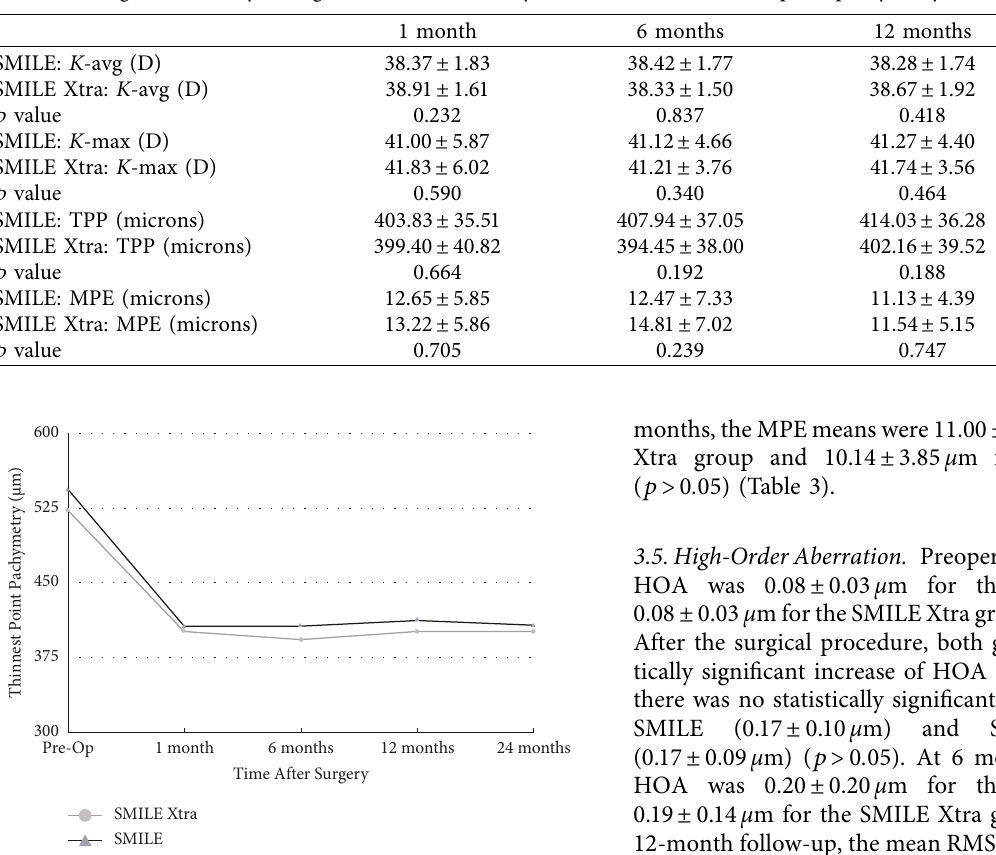
Table 3: K -avg: Keratometry average; K -max: Keratometry maximum; TPP: thinnest point pachymetry; maximum posterior elevation.